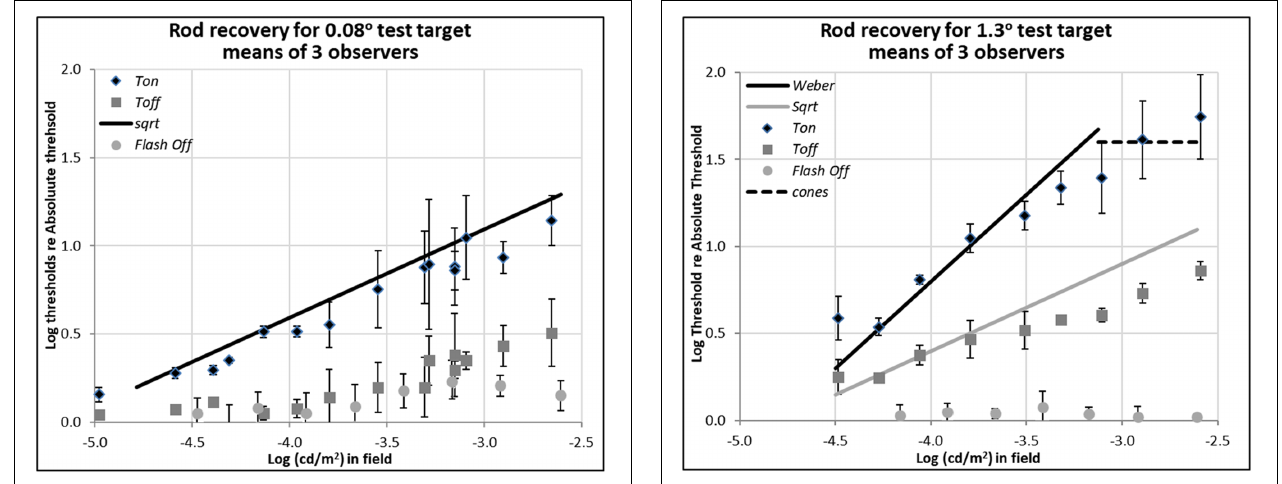
FIGURE 2 | Plots of rod thresholds for detecting a small target (0.08 ◦ ), either on a steady field ( Ton ) or 600 ms ( Toff ) or 200 ms ( Toff-flash ) in darkness, relative to Tabs. Thresholds were averaged over three observers and are plotted as a function of log (cd/m 2 ) in the background field. Bars denote ± 1 standard error of the mean. Solid black line indicates the square-root prediction.